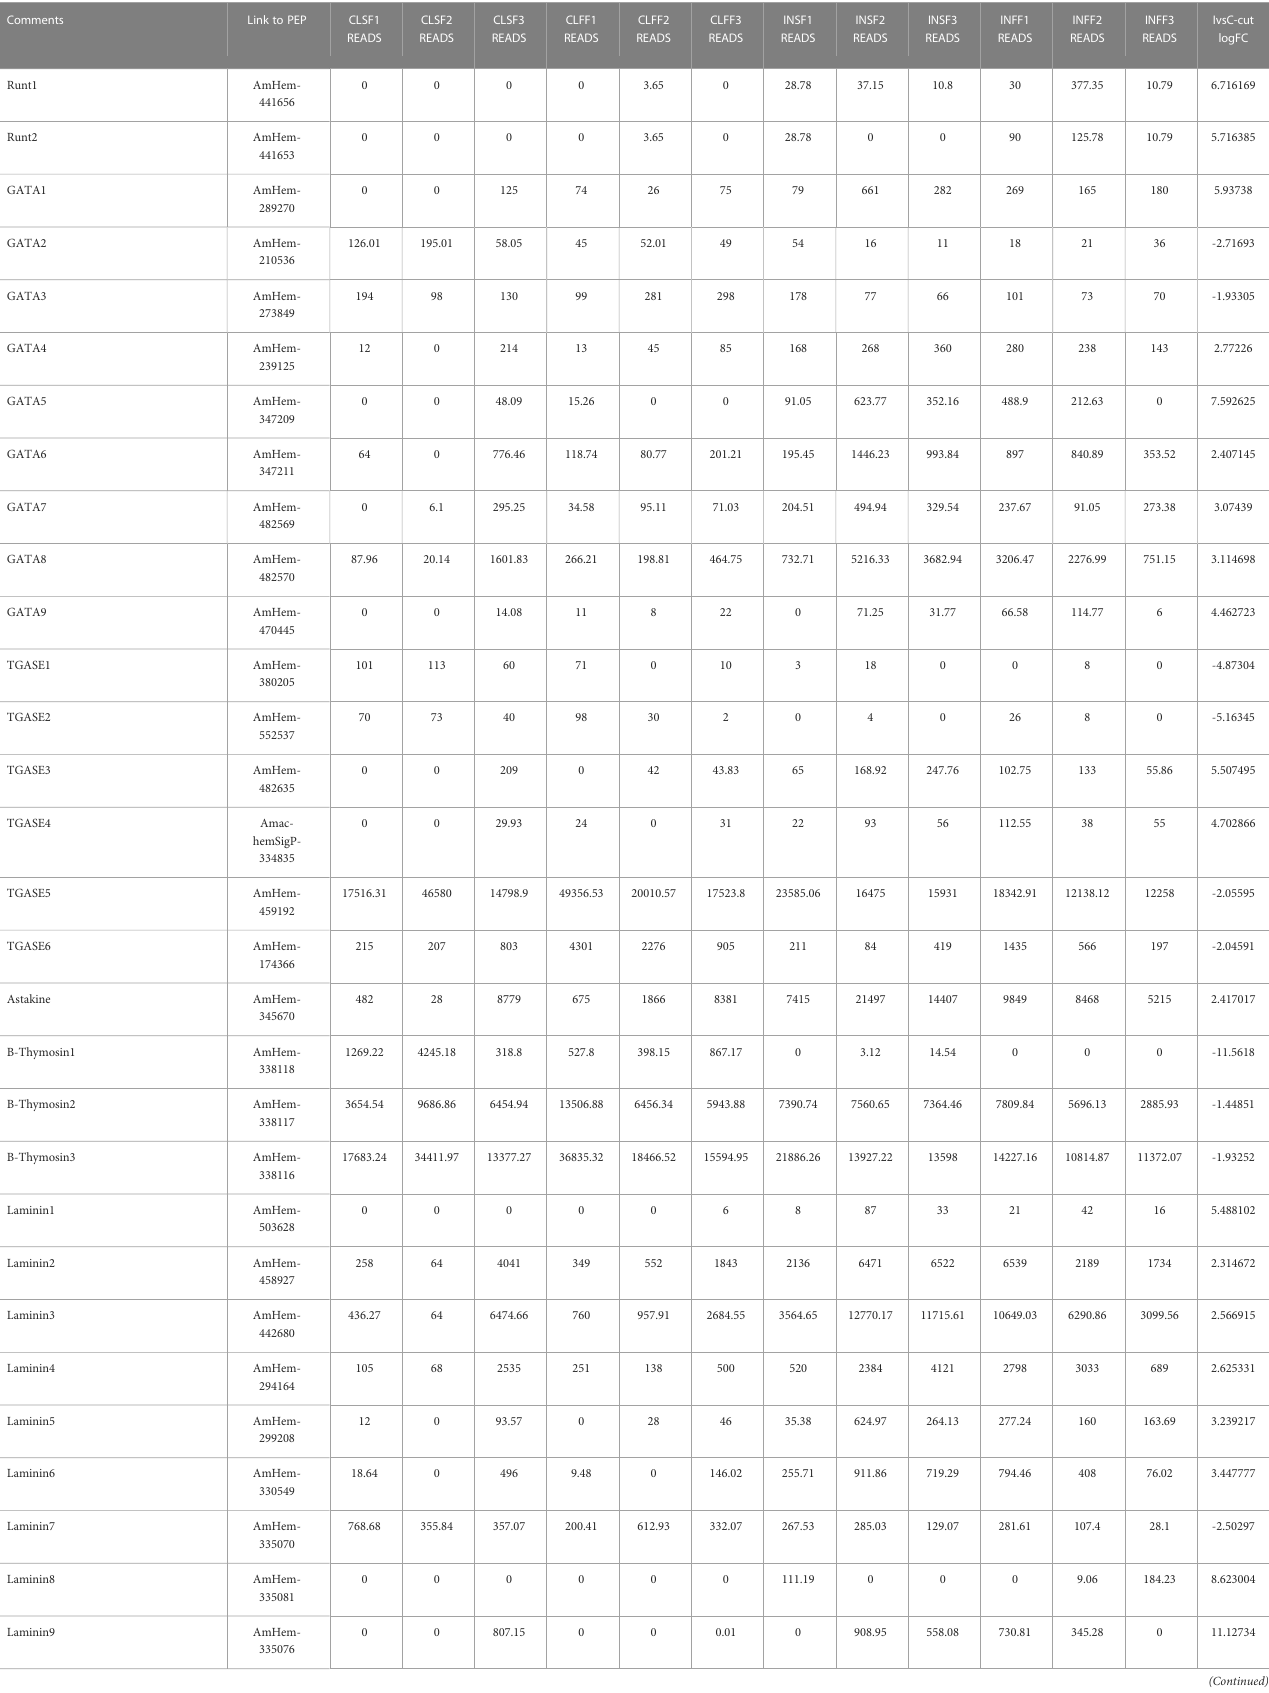
TABLE 2 Differentially expressed transcripts of hematopoietic, hemocyte functions and immunity rekated genes in Am. maculatum hemocytes with and without R. parkeri.